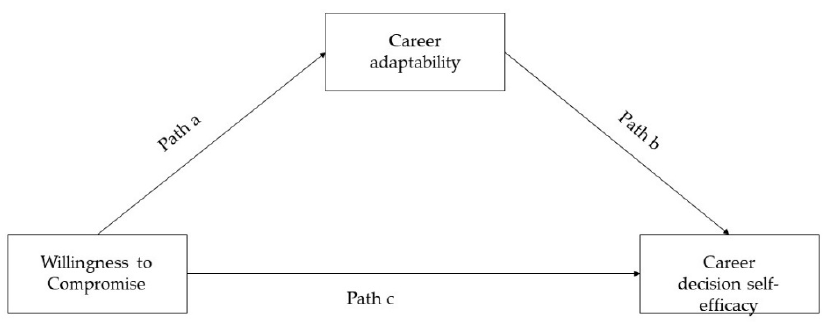
Figure 2. Statistical Diagram.